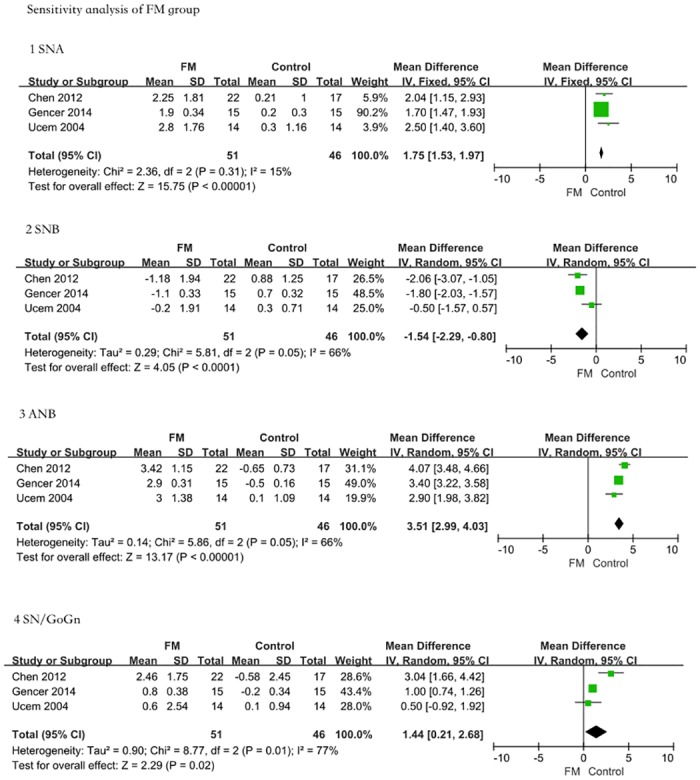
Sensitivity analysis.In the FM group, we chose 3 relatively high-quality studies (score ≥4) to carry out the sensitivity analysis. 1: Angle SNA. The FM treatment group presented a greater increase in SNA than the controls (MD = 1.75, 95% CI = 1.53–1.97, P < 0.00001). 2: Angle SNB. The FM treatment group presented a greater decrease in SNB than the untreated controls (MD = -1.54, 95% CI = -2.29–-0.80, P < 0.0001). 3: Angle ANB. The FM treatment group presented a greater increase in ANB than the controls (MD = 3.51, 95% CI = 2.99–4.03, P < 0.00001). 4: Angle SN/GoGn. The FM treatment group presented a greater increase in SN/GoGn than the controls (MD = 1.44, 95% CI = 0.21–2.68, P = 0.02). The sensitivity analysis results were consistent with previous results.